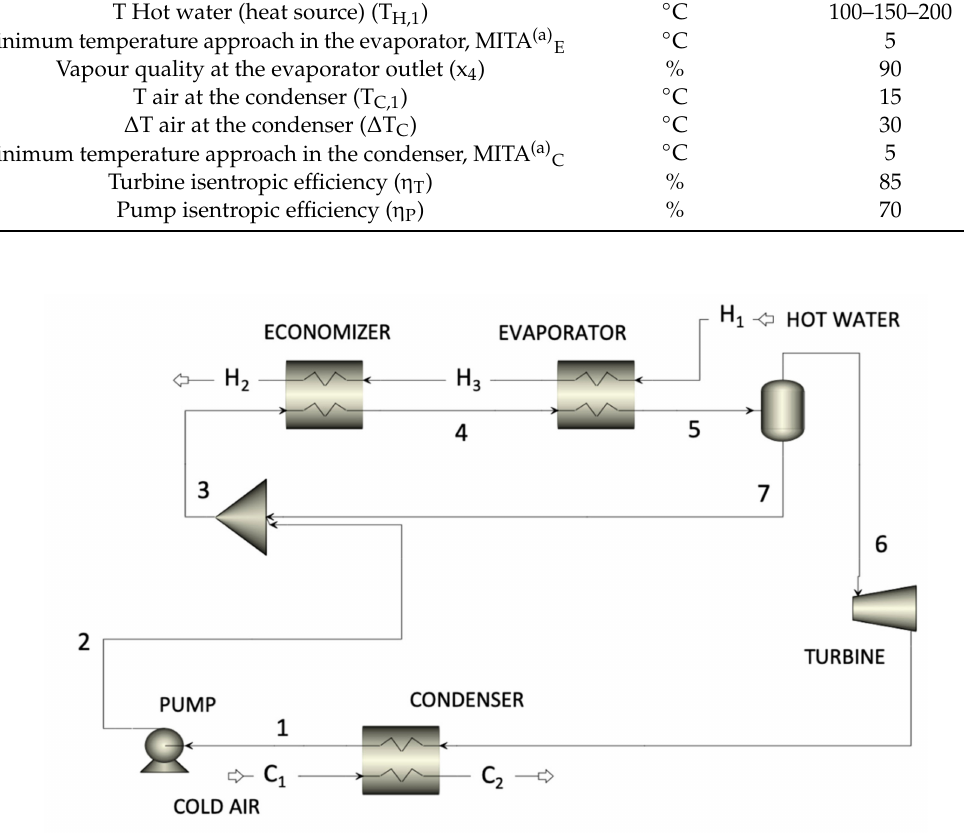
Figure 7. Organic Rankine cycle layout: Aspen Plus